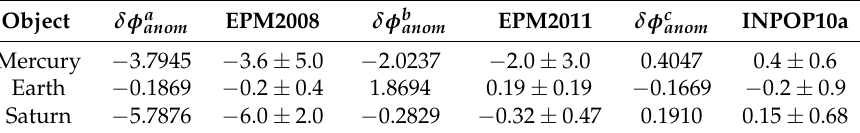
Table 2. Comparison between the values for anomalous apsidal precession for selected planets.